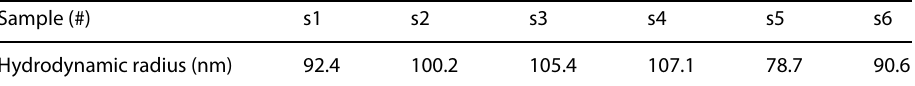
Table 6 Hydrodynamic radius of Au/Ag BNPs and monometallic gold and silver